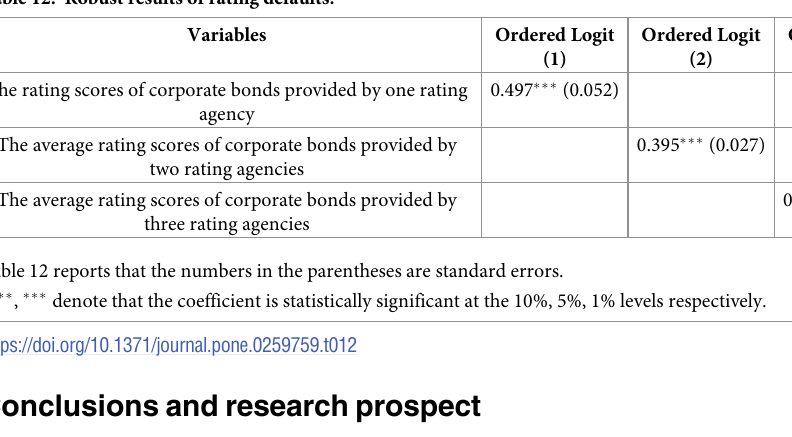
Table 12. Robust results of rating defaults.